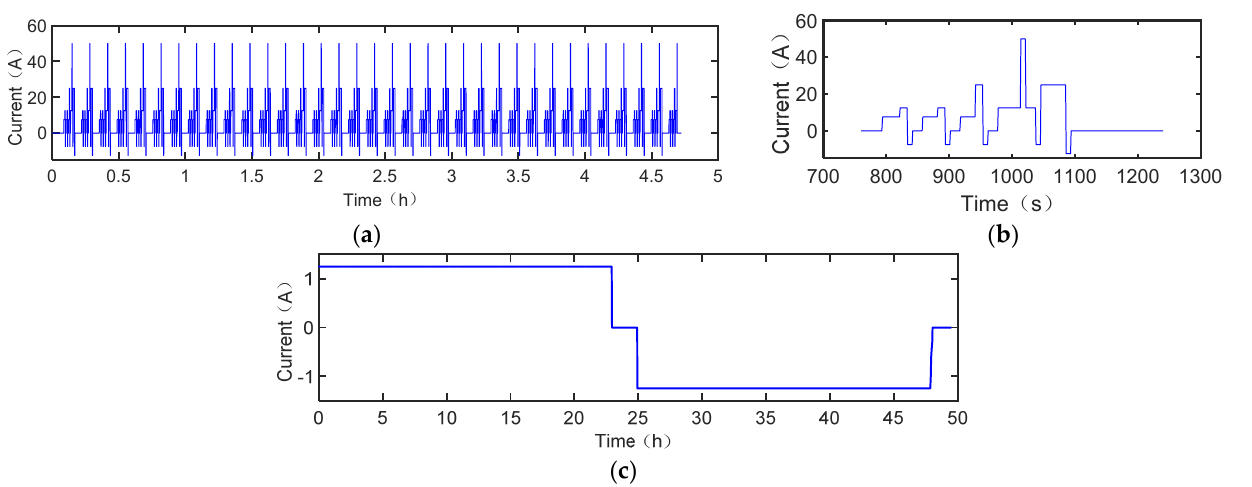
Figure 8. Current profiles of: ( a ) DST. ( b ) Cycle window of DST. ( c ) low-current OCV test. Table 3. Basis information of tested batteries.